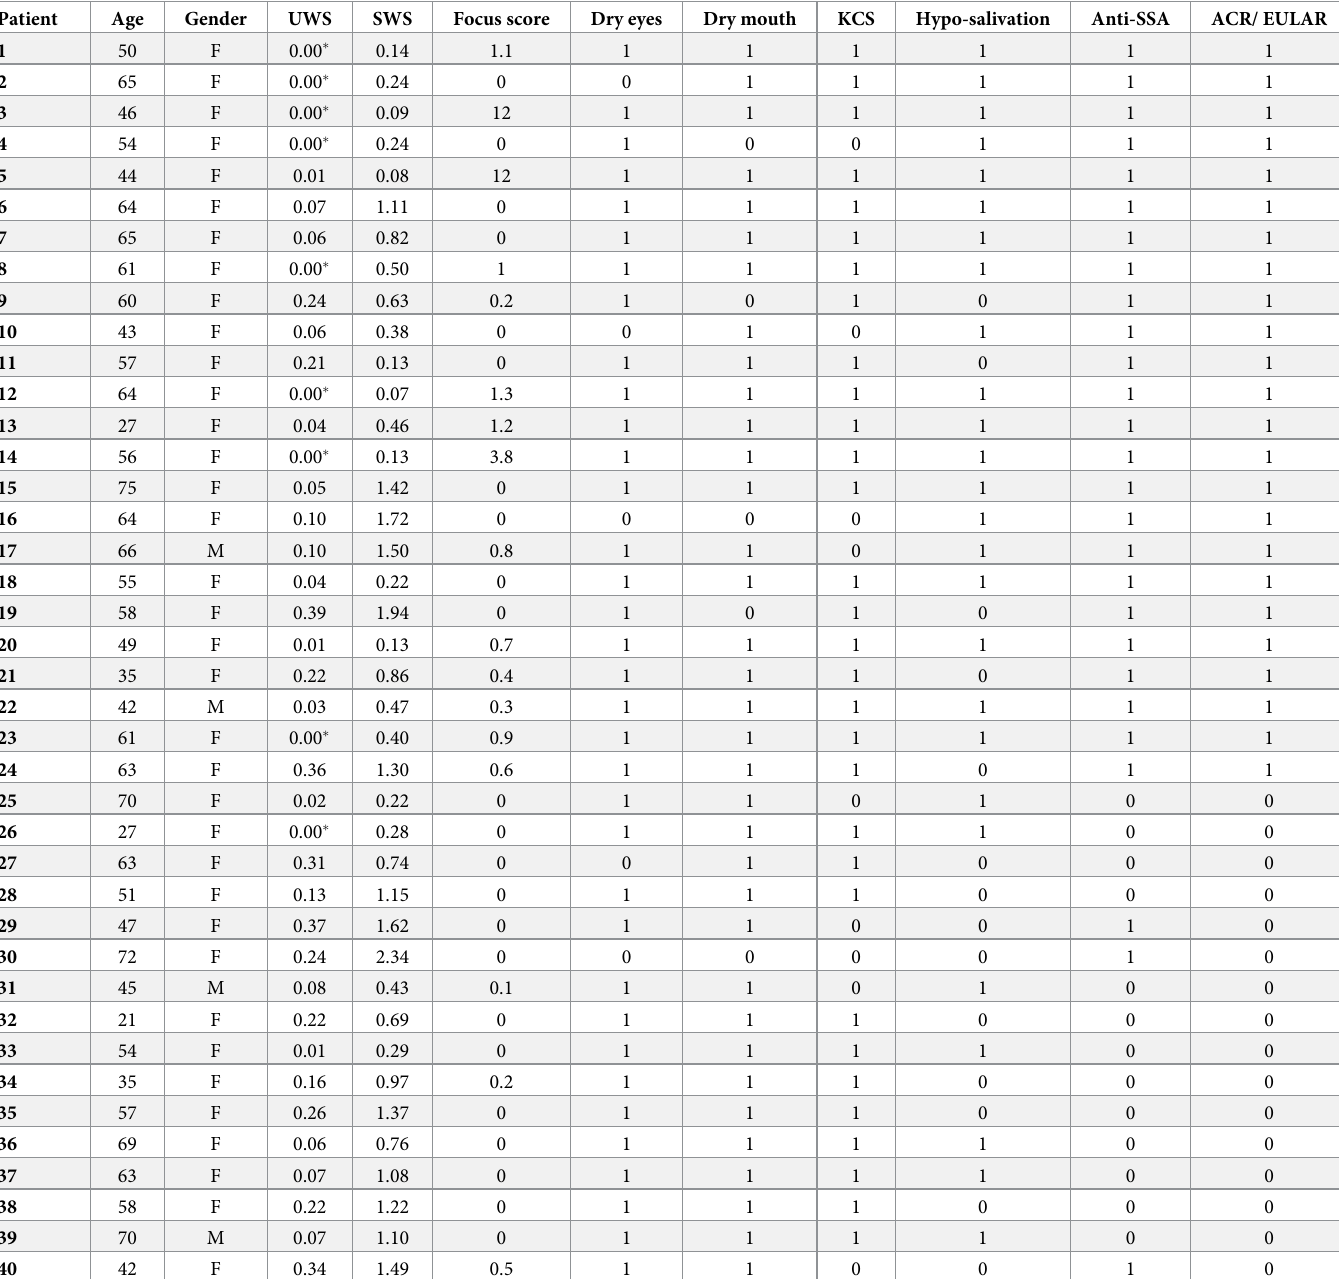
Table 2. Demographic and clinical data based on